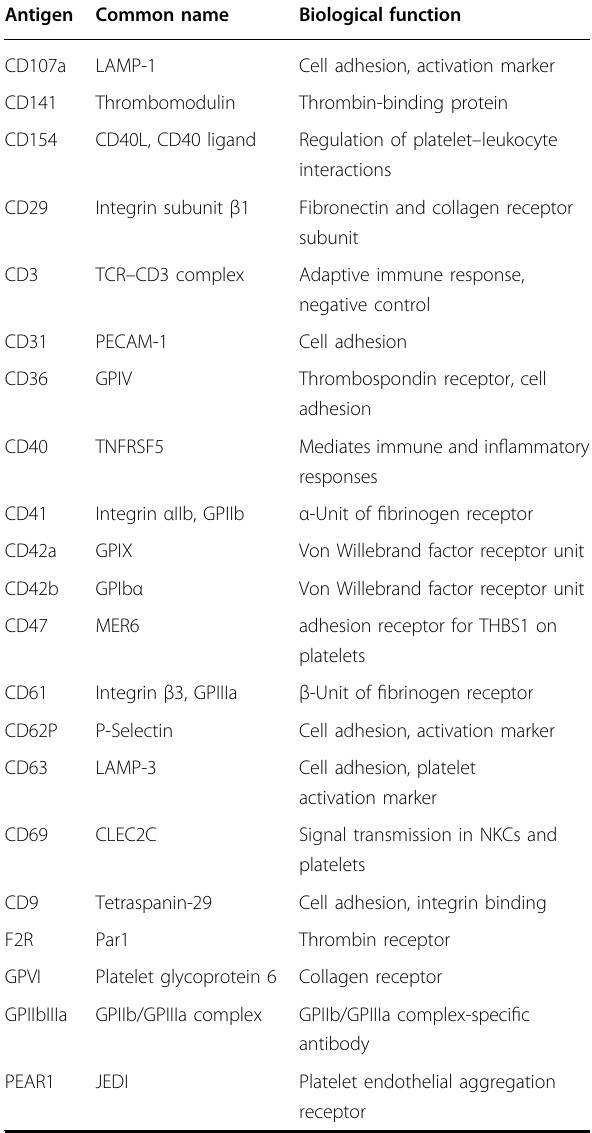
Table 1 Mass cytometry